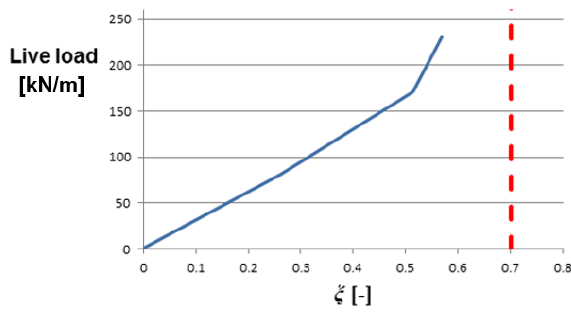
Figure 13: Porta Napoli bridge. Brittle hinges at the springings: Damage rate vs live